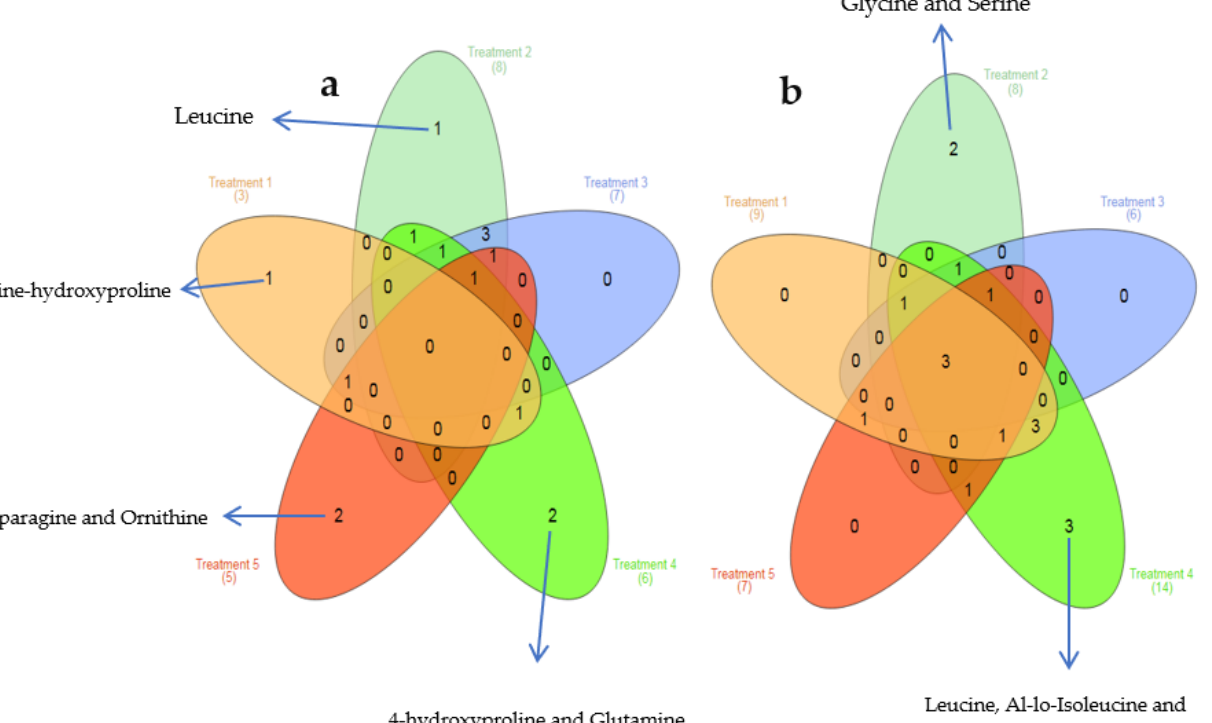
Figure 3. Venn diagram of the altered amino acids in all treatments. ( a ) Increased amino acids within all experimental groups. Unique increased amino acids were labelled next to each respective treatment ( b ) Indicates all amino acid that were decreased all treatments. Exclusive decreased amino acids were labelled beside respective treatment.